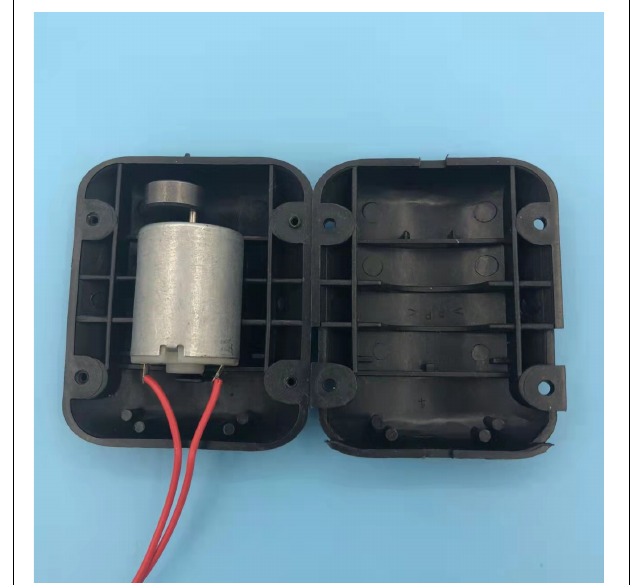
FIGURE 2 | The vibration